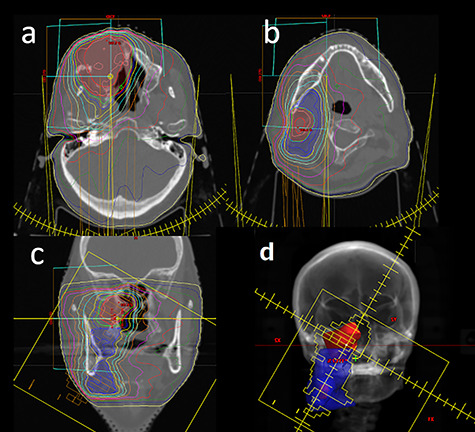
A representative case treated with intensity modulated radiotherapy is shown. (a) Axial CT image at the level of primary tumor. (b) Axial CT image at the level of lymph node metastasis. (c) Coronal CT image. (d) Beam’s eye view of the treatment plan. The primary tumor is shown in red mesh and the neck lymph node area is shown in blue mesh. Blue line, 95% isodose line of prescribed dose.